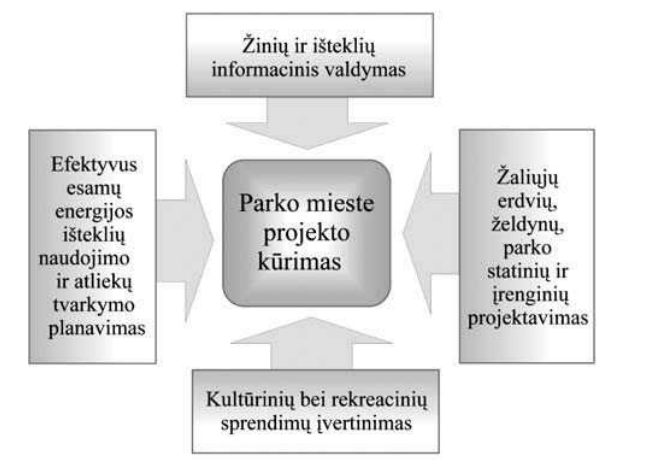
Fig 3. Some factors influencing park design